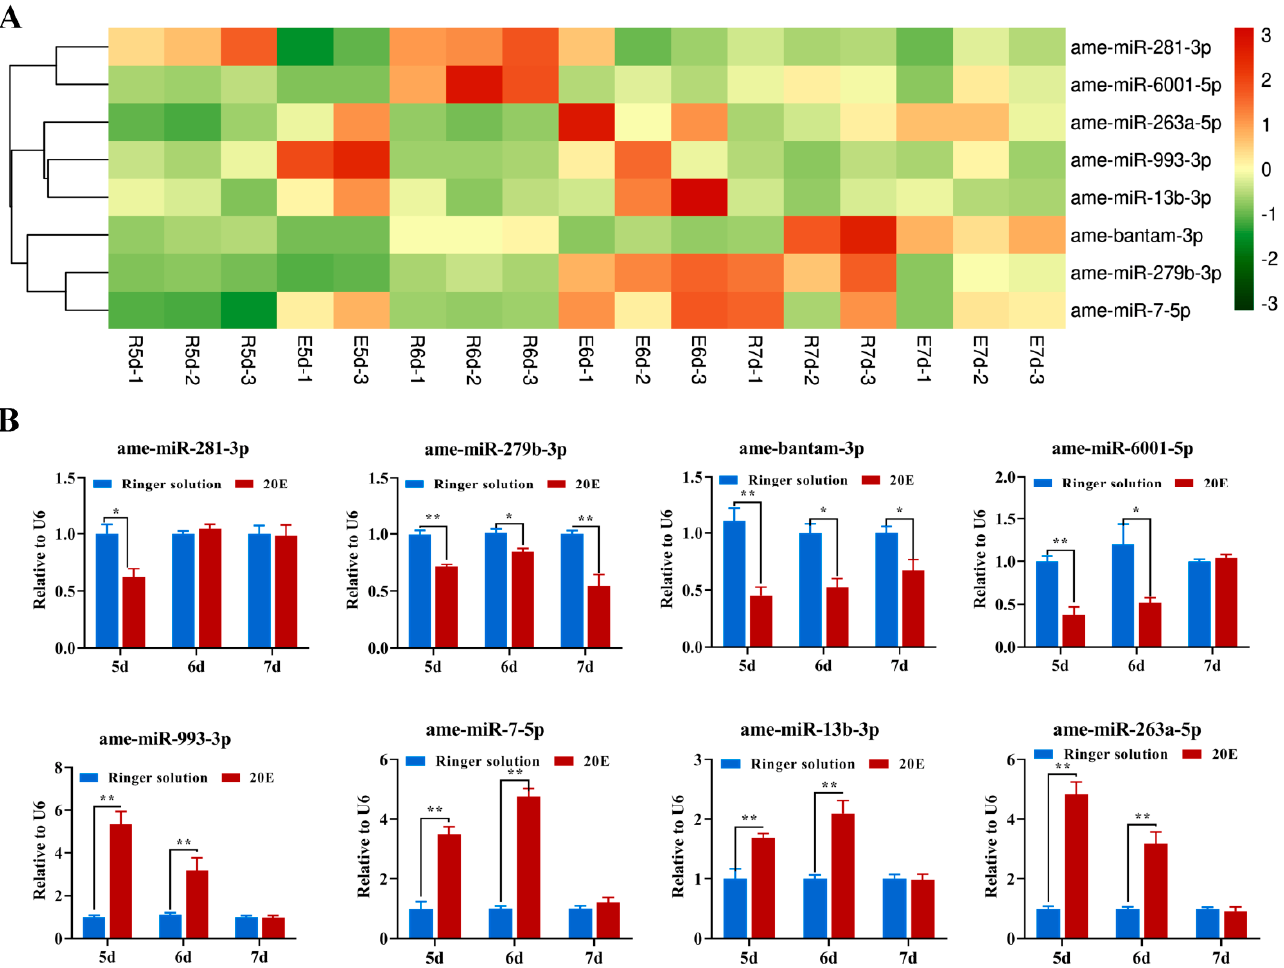
Figure 3. Validation of eight selected differentially expressed (DE) miRNAs by RT-qPCR. ( A ) Hierarchical cluster analysis of eight selected DE miRNAs at different developmental stages in honeybees. ( B ) Determination of eight selected DE miRNAs by RT-qPCR. Three biological replicates and three technical replicates were performed. * p < 0.05, ** p < 0.01 (Student’s t -test). The values are means ± SEM. Table 1. miRNA count among different tissues.